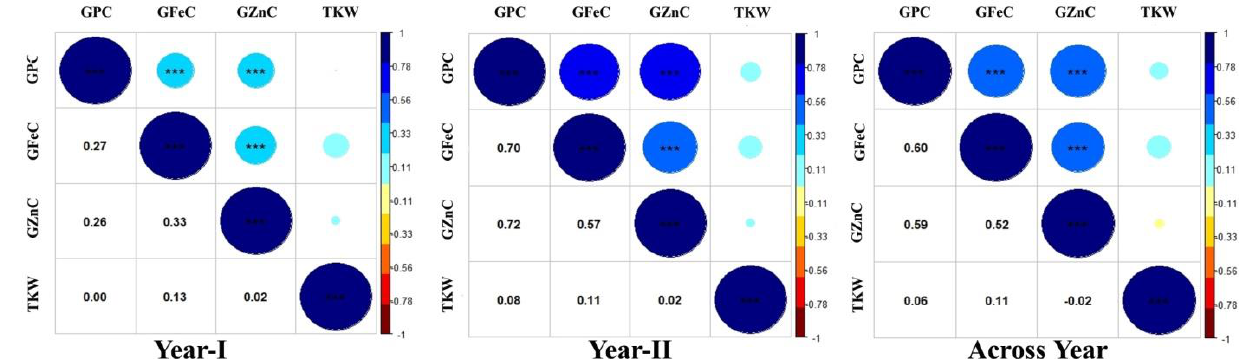
Figure 3. Genetic correlation coefficients among GFeC, GZnC, GPC, and TKW in RIL population grown at ICAR-IARI during 2017 – 18 (year I) and 2018 – 2019 (year II) and across years. *** significant values at p < 0.001.